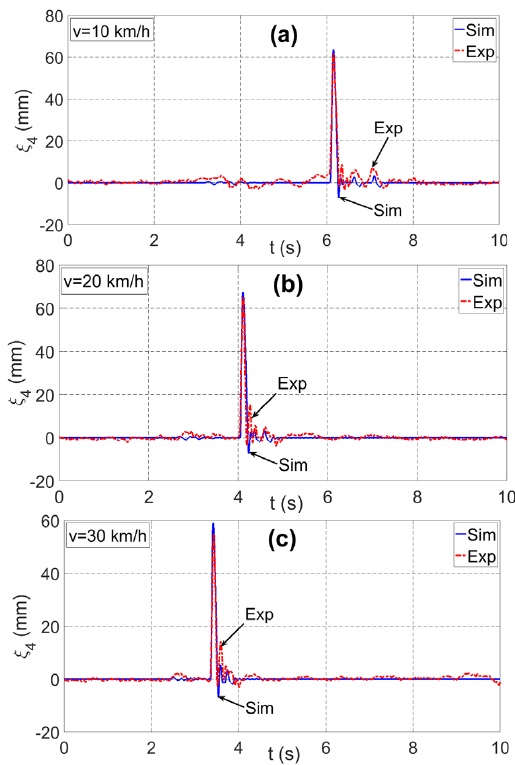
( c ) at 30 km/h. 30 km/h .